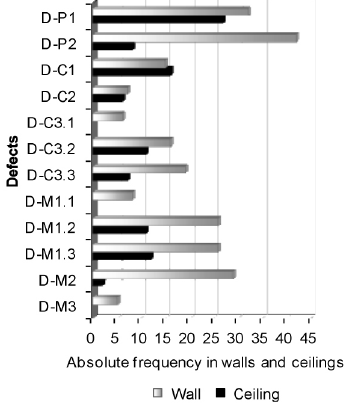
Fig. 4. Absolute frequency of defects in walls and ceilings